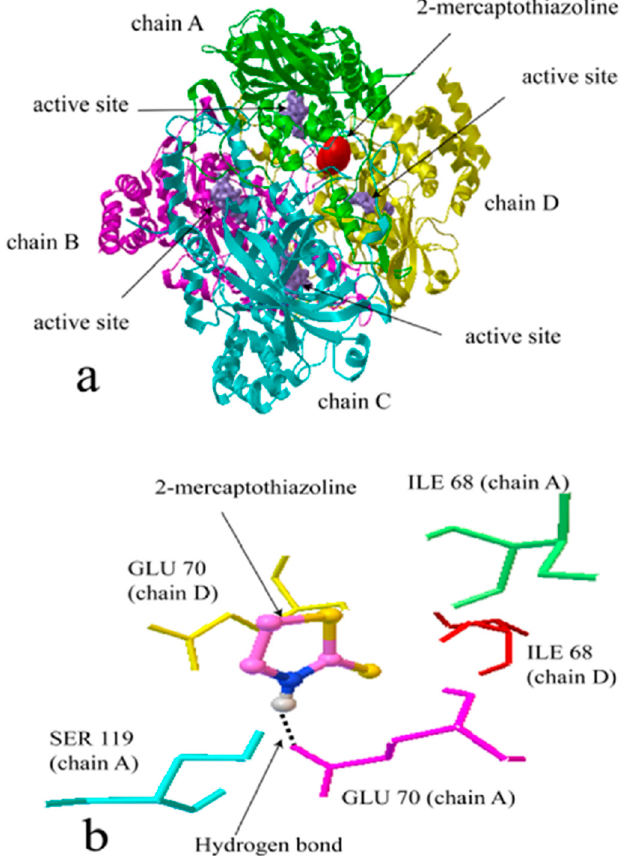
Figure 4. Molecular docking for the interaction between CAT and 2-MT. ( a ) Binding site of 2-MT to CAT; ( b ) Detailed illustration of the binding between CAT and 2-MT.